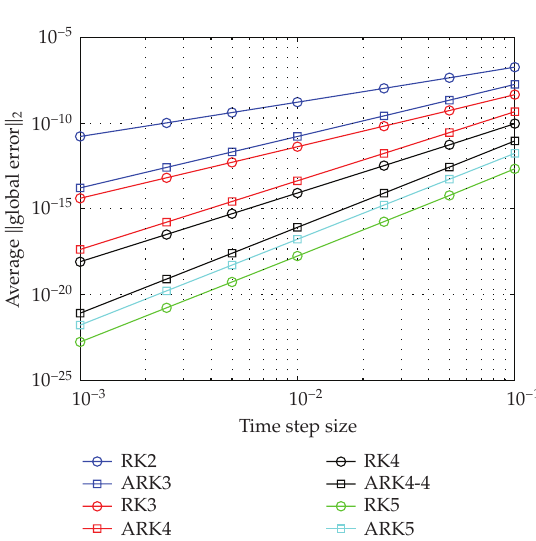
Figure 2: Accuracy plot for IVP-1 using log-log scale. The RK methods are shown by lines with circles. The ARK methods are shown by lines with squares. Lines of the same color correspond to methods with the same number of function evaluations per time step.